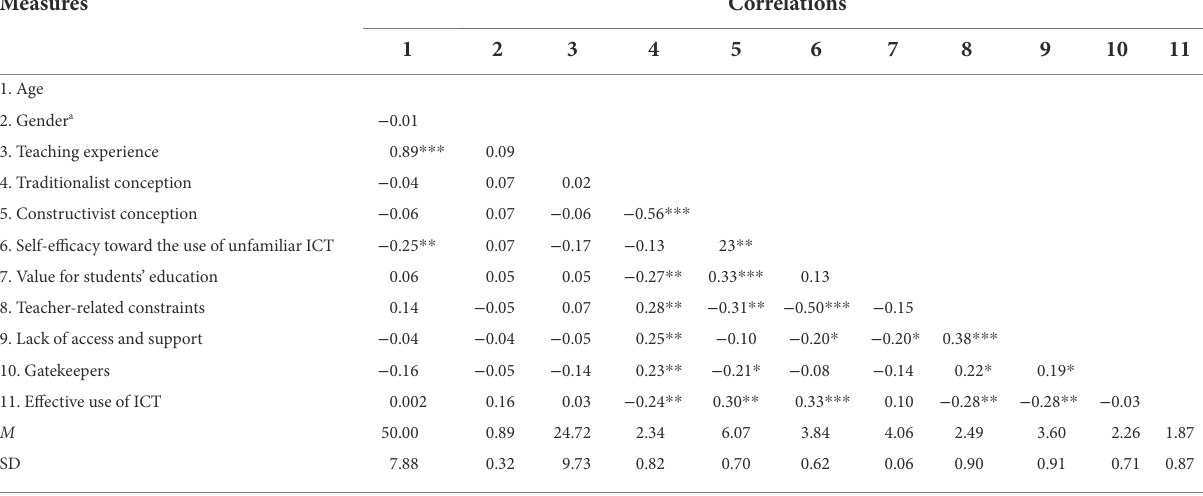
TABLE 2 Means, standard deviations, and correlations for all variables.